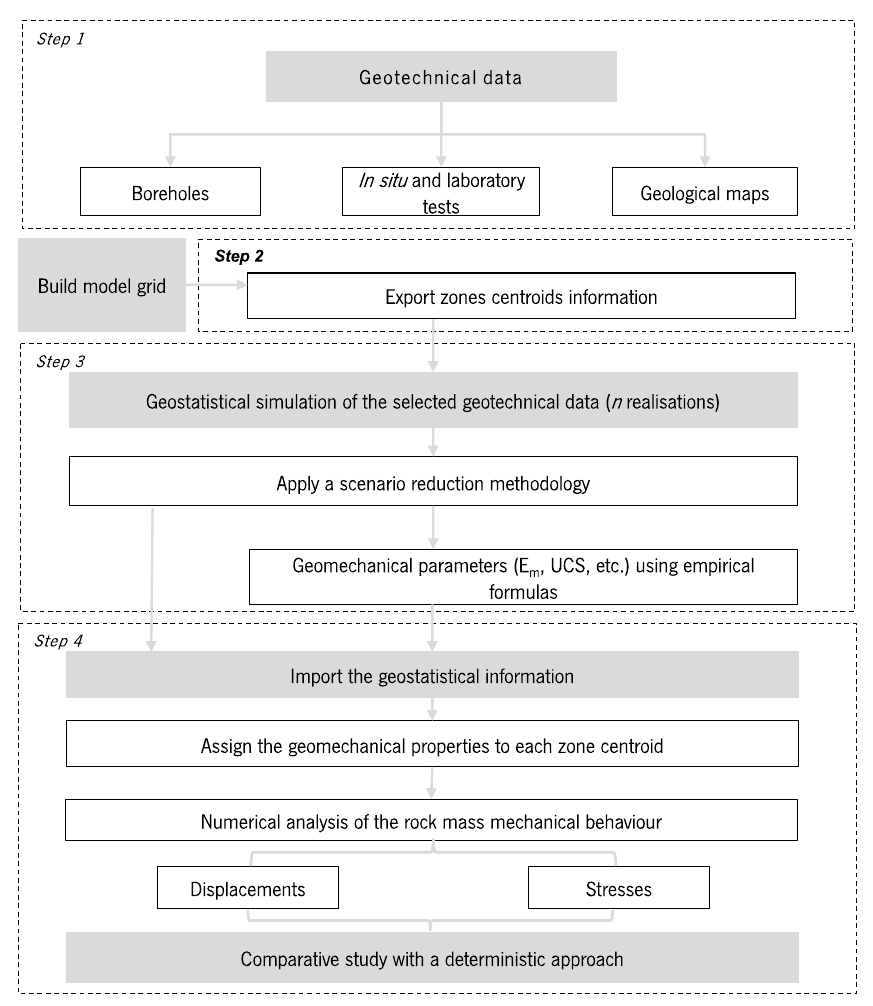
Figure 1. Main steps of the proposed methodology. UCS: Uniaxial Compressive Strength.